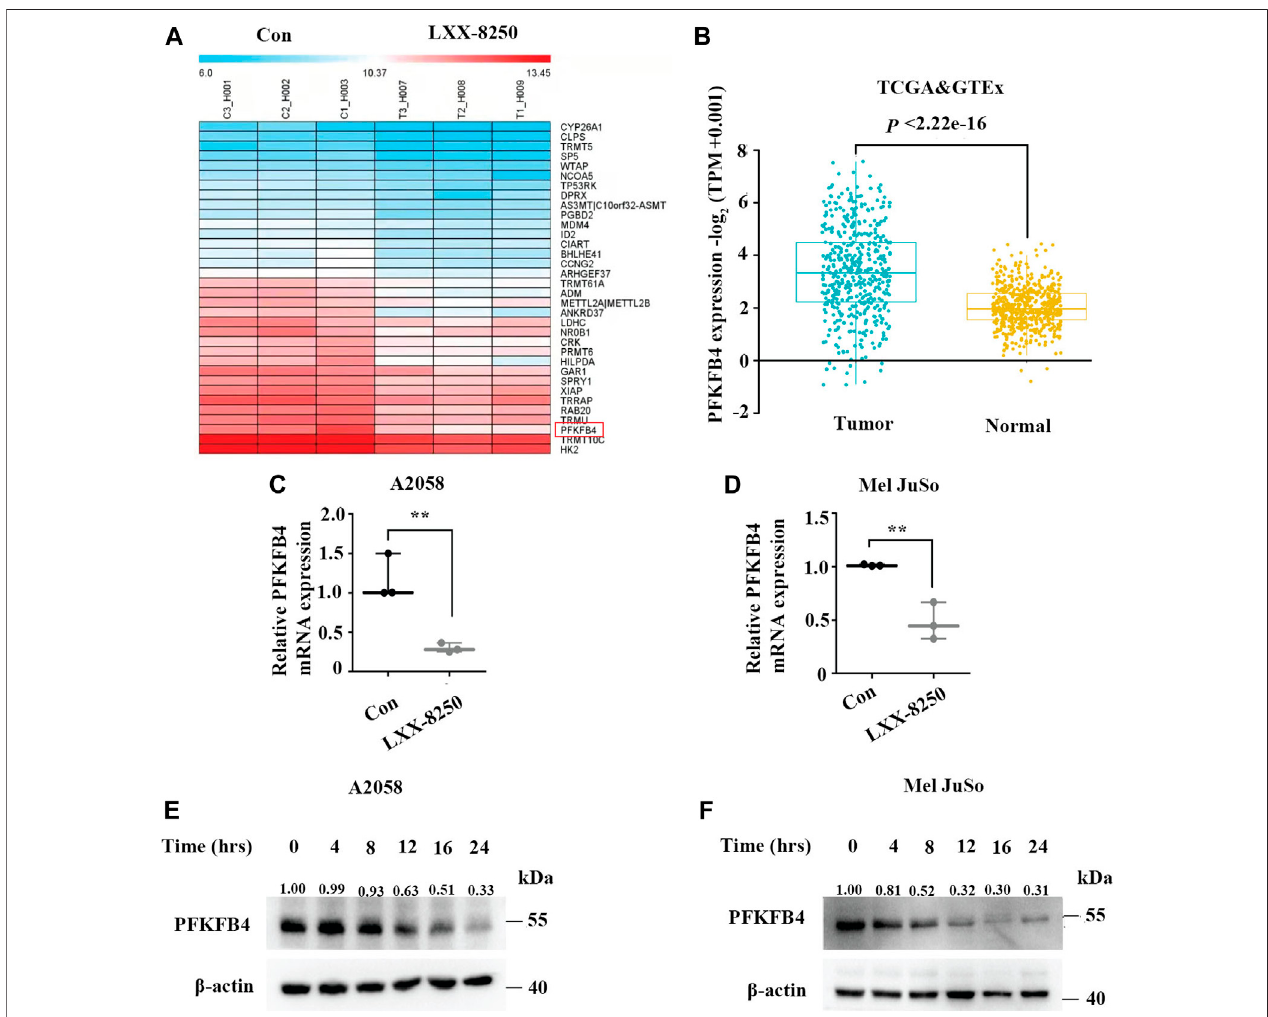
FIGURE 3 | Effects of LXX-8250 on PFKFB4 expression. (A) Heatmap for the representative downregulated genes in LXX-8250 (14.6 μ M) treated cells compared withcontrolcells,asevaluatedbymicroarrayanalyses(foldchange > 1.5, p < 0.05). (B) TherelativePFKFB4mRNAexpressionlevelsinSKCMdatafromTCGAcombined with Skin data from GTEx data. Tumor, 469 cases; Normal, 557 cases. (C,D) Real time PCR analyses for the cells treated with LXX-8250 14.6 μ M, (C) ; 22.8 µM, (D) . (E,F) WesternblotanalysisforthecellstreatedwithLXX-825014.6 μ M, (E) ;22.8 µM, (F) fortheindicatedtimes.Thequanti fi cationresultsofthebanddensitywere labeled above the bands. Data represent mean ± SD. ** p < 0.01, *** p < 0.001.